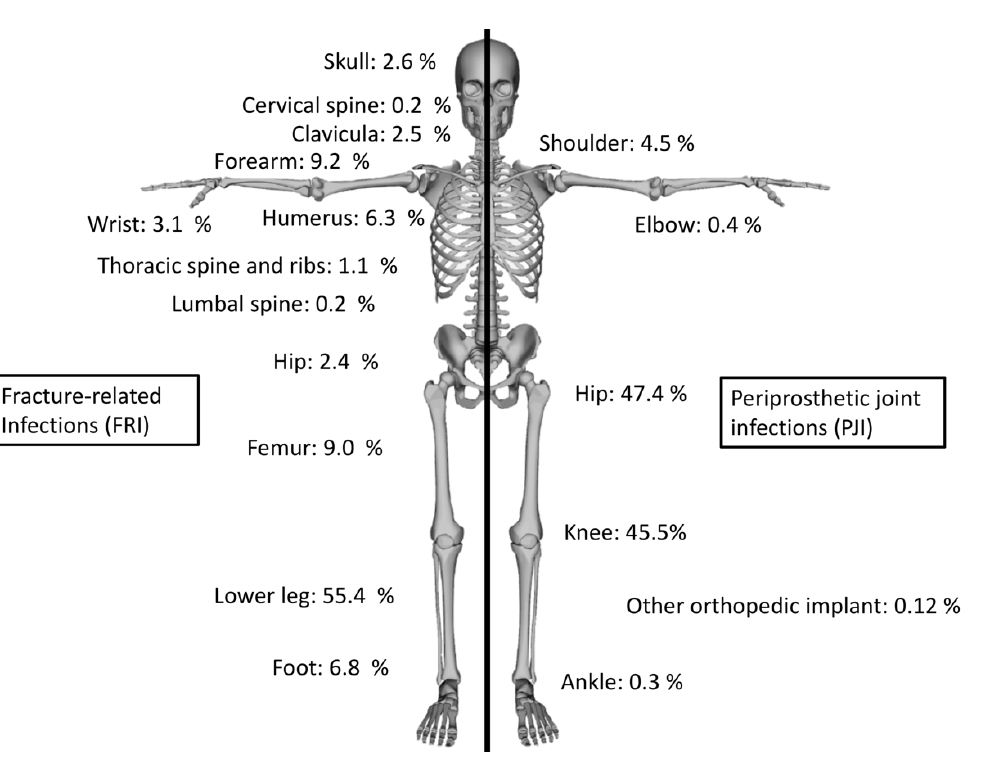
Figure 1. Proportional distribution of the localization of fracture-related infections and periprosthetic joint infections. Table 1. Absolute number and proportion of comorbidities of fracture-related infections and periprosthetic joint infections with statistical difference between FRI and PJI.